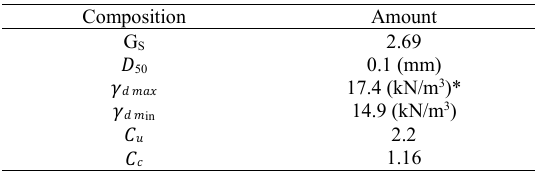
Table 1: Specifications of the testing soil